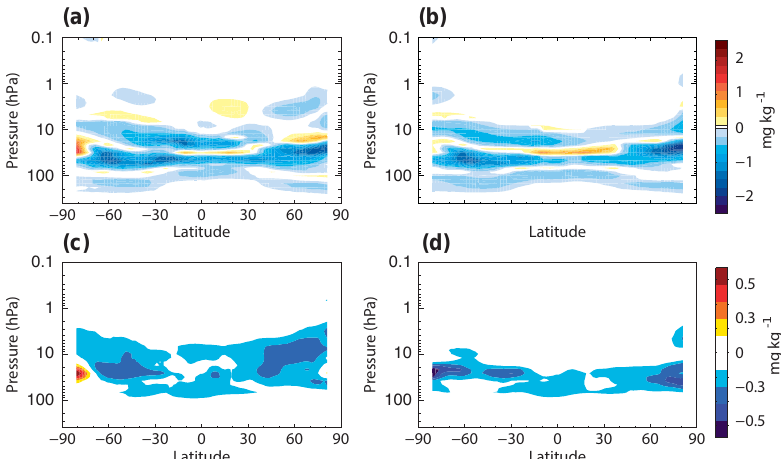
Figure 9. (a, b) Change in the zonal mean differences between the MLS retrievals and co-located ozone analyses from the perturbation experiment compared to the Exp/Ctrl for August–October 2008. The perturbation experiment is Exp/GOME2 in panel (a) and Exp/MIPAS in panel (b) . Negative (positive) values in blue (red) colours indicate a decrease (an increase) in the mean in the control and thus a degraded fit to MLS ozone profiles. Data are in mgkg − 1 . The colour scale ranges from − 2.5mgkg − 1 (dark blue colour) to + 2.5mgkg − 1 (dark red colour) with a step of 0.25mgkg − 1 . (c, d) Like in the top panels but for the standard deviation of differences. The colour scale ranges from